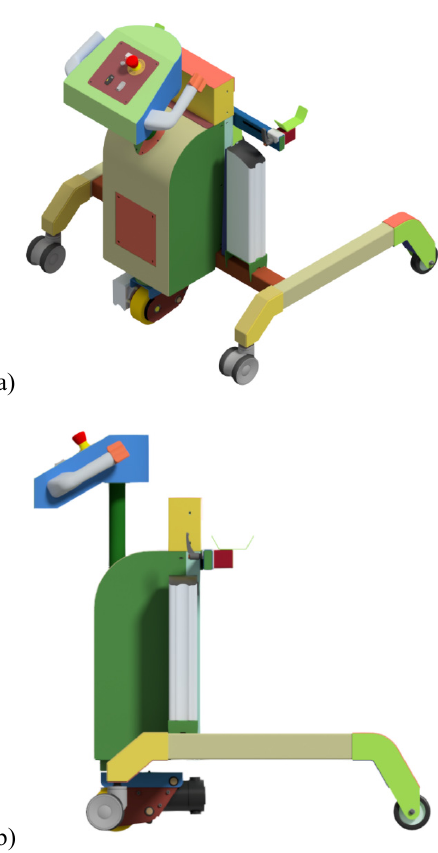
Figure 6. General representation of the final designed equipment: isometric (a) and side views (b).